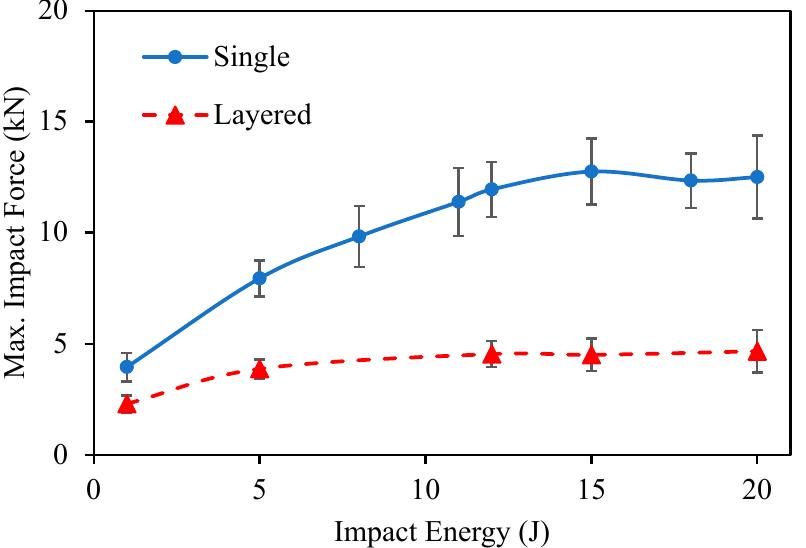
Figure 5. Variations of the maximum impact force for both baseline and layered PMMA specimens as a function of impact energy. Table 1. Maximum impact force for baseline and layered PMMA specimens.